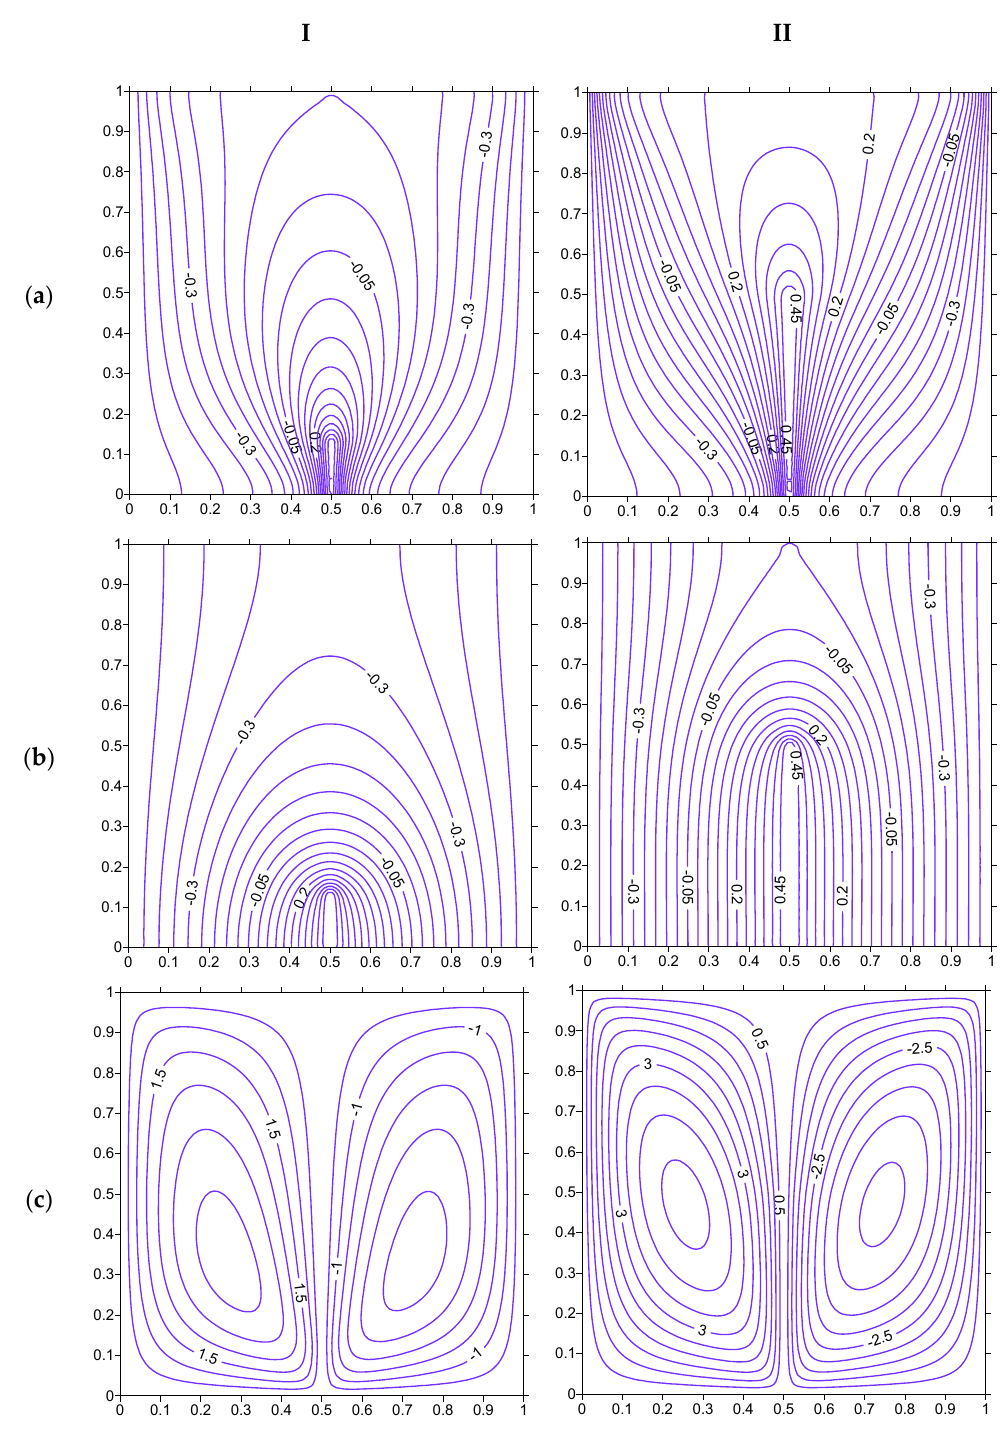
Figure 7. Isotherms (( a ) Fluid, ( b ) Solid) and streamlines ( c ), at Ra = 100, H = 5, Kr = 1, Rd = 0 for strip at x = 0.5. ( I ) HH = 12.5%. ( II ) HH =